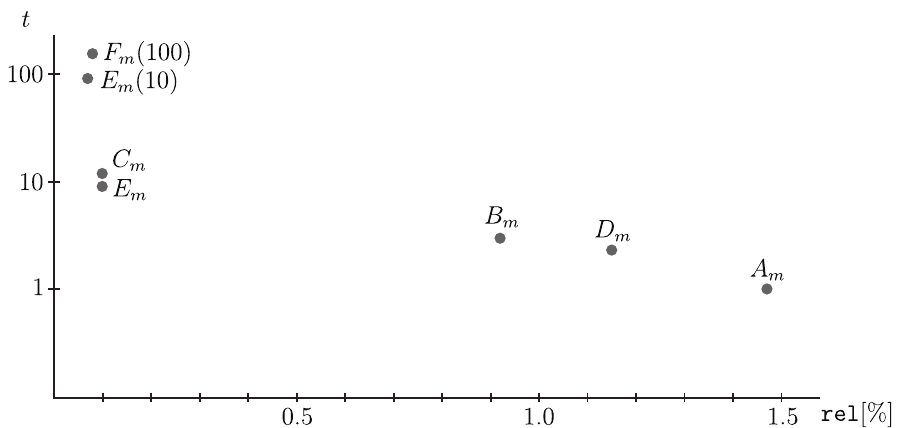
Figure 8. This diagram contains graphical representations of average (normalized) times (in logarithmic scale) needed for non-binary instances from [30] computed in Table 3 and relative errors rel (with respect to the optimal value OPT ). Algorithms A m , B m , C m , D m , and E m are considered fast, while E m (10) and F m (100) are comparably